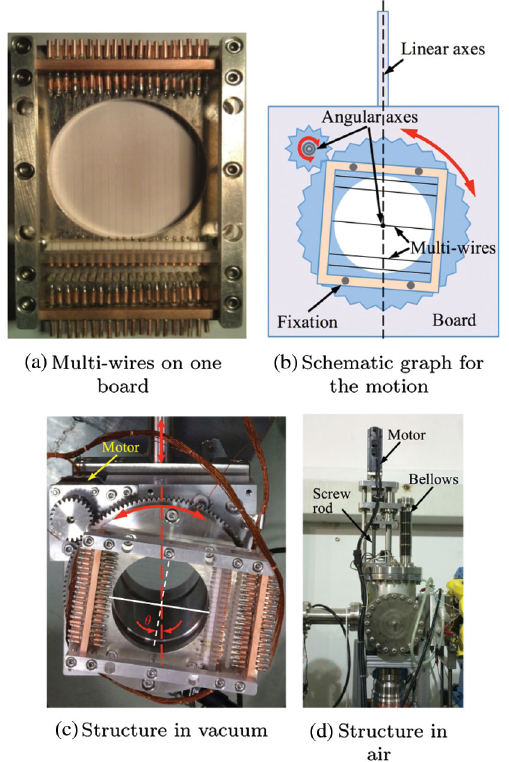
FIG. 6. Mechanical design of the rotatable wire scanner